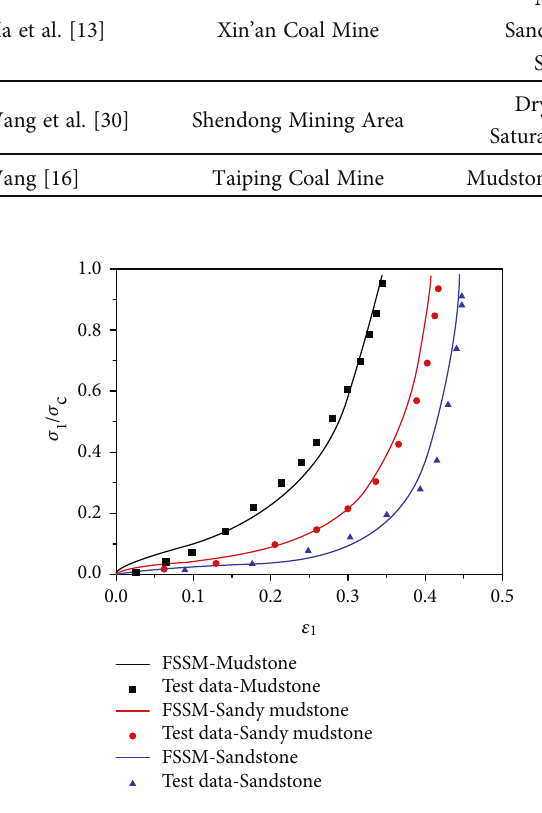
Figure 5: Stress-strain curves of the broken rock with di ff erent